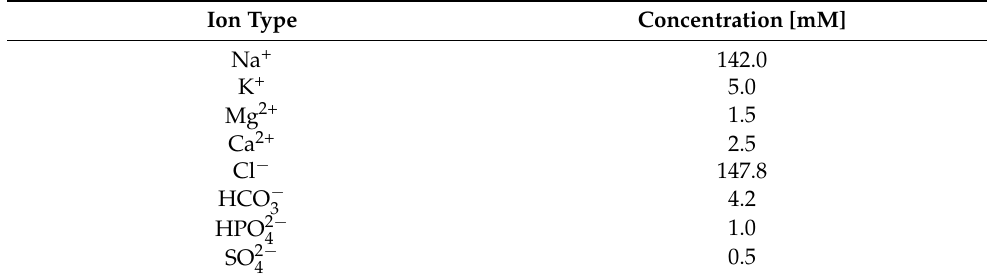
Table 1. Composition of the SBF solution used for the test of the bioactivity of the tested